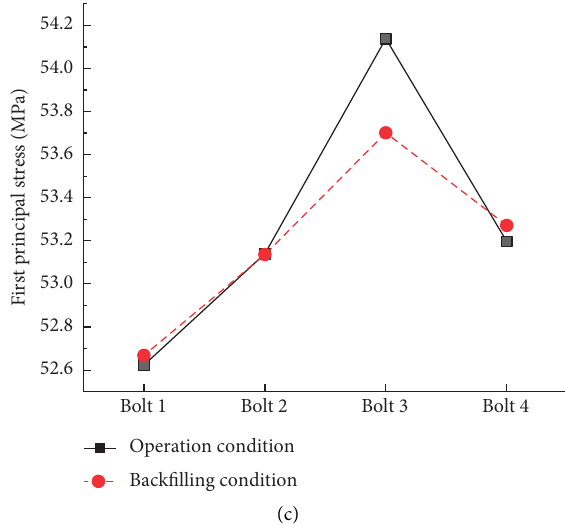
Figure 11: Comparison of operation and backfilling conditions. (a) Third principal stress of concrete on the inner surface of side wall. (b) First principal stress of concrete on the inner surface of the roof. (c) Maximum stress of connecting